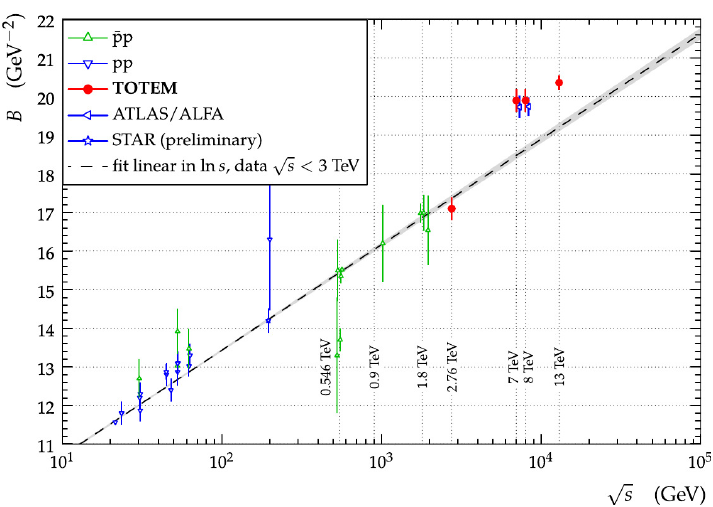
Figure 1. The energy dependence of the slope B of the diffraction cone